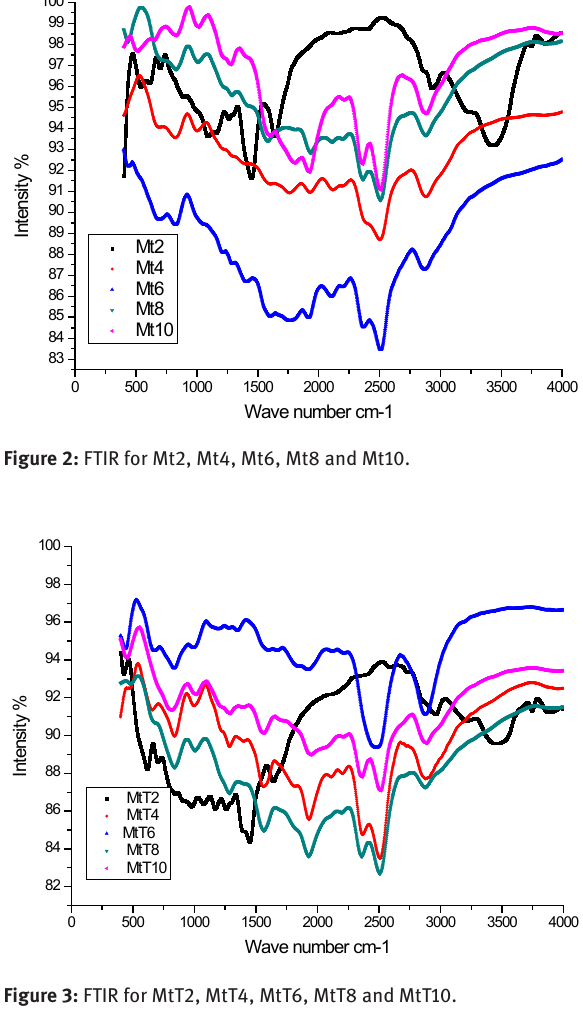
Figure 3: FTIR for MtT2, MtT4, MtT6, MtT8 and MtT10.